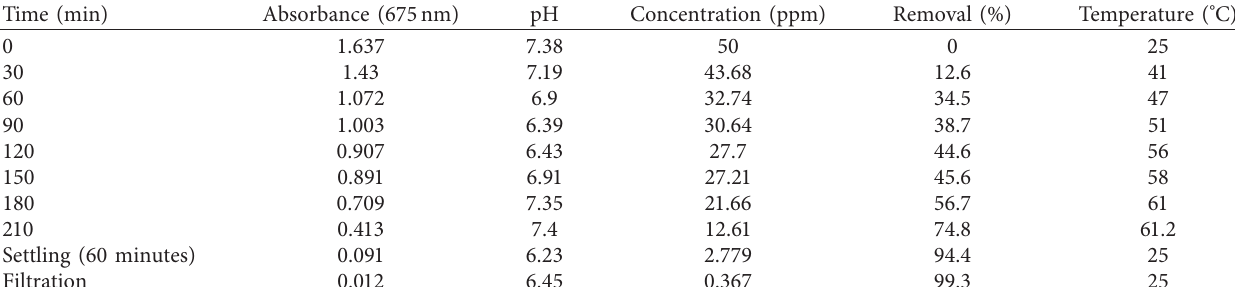
Table 1: Different characteristic values of red dye in the absence of acid and base.